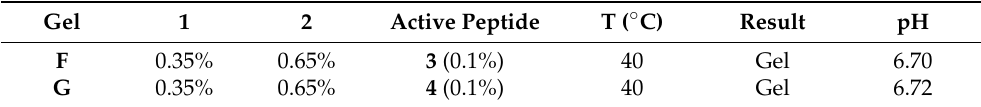
Table 2. Summary of the hydrogels containing peptides 1 and 2 and the active peptides 3 (gel F ) and 4 (gel G ). The % are expressed as w/V.